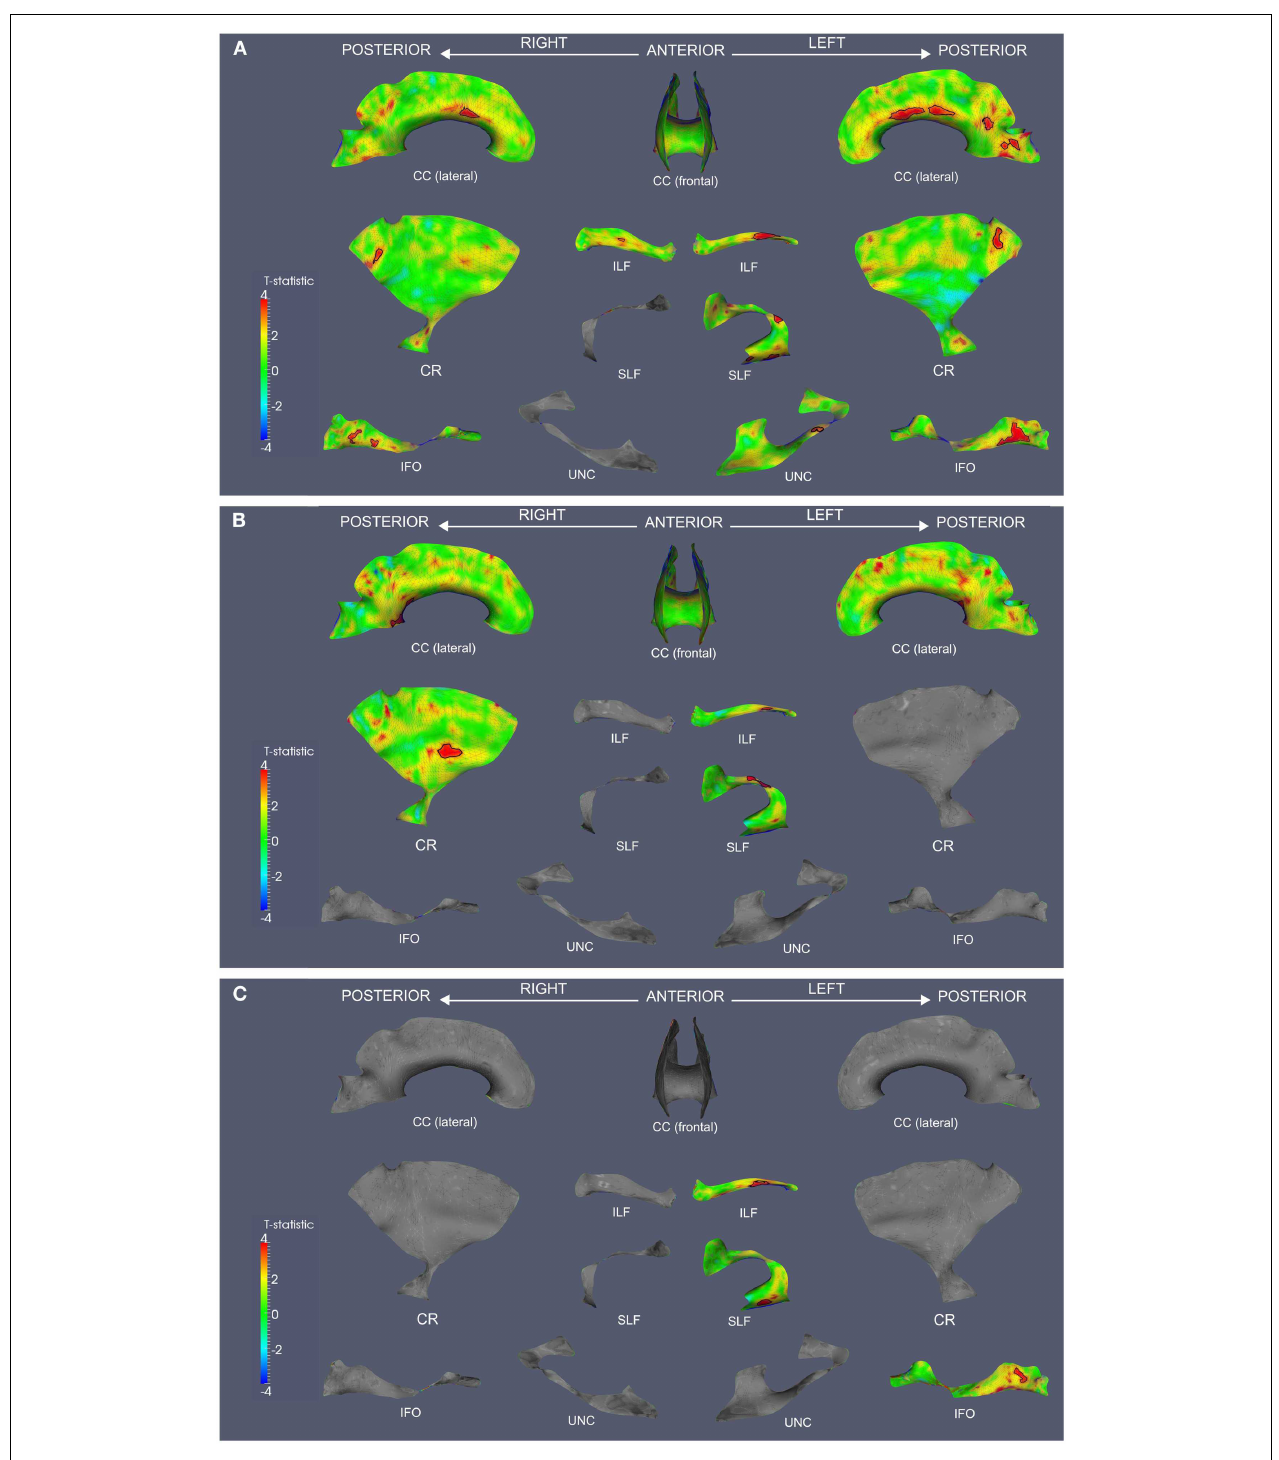
FA (C) . In all panels, red corresponds with higher t -values, and statistically significant clusters are outlined in black. CC, corpus callosum; CR, corona radiata; ILF, inferior longitudinal fasciculus; SLF, superior longitudinal fasciculus; IFO, inferior fronto-occipital fasciculus; UNC, uncinate